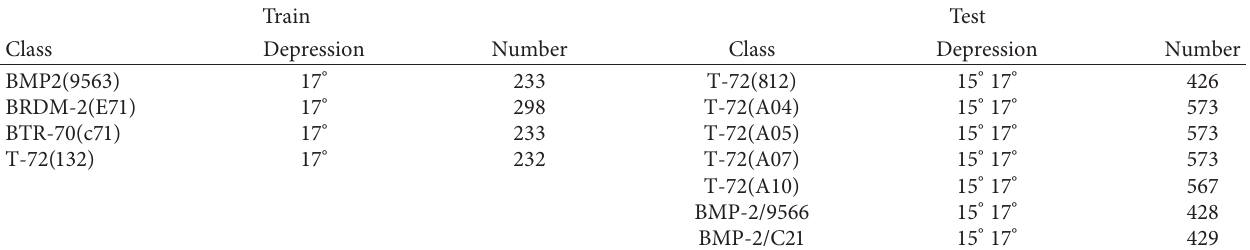
Table 3: Number of training and test samples for EOC-2 (version variants). Train